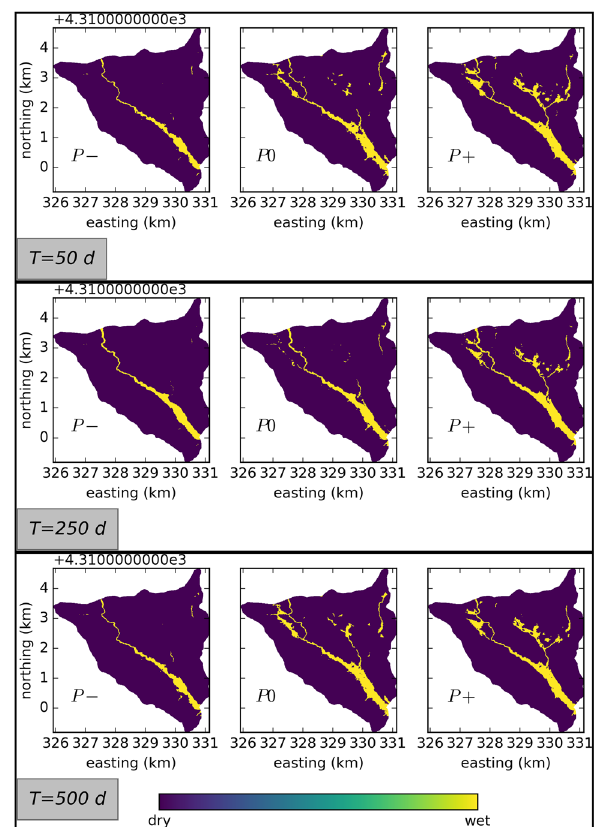
Figure 3. Snapshots of the spatial patterns of wetting and drying at the surface. T = 50 d: low flow conditions in the first water year, T = 250 d: rising limb in the first water year, T = 500 d: low flow conditions in the second water year, shortly before the rising